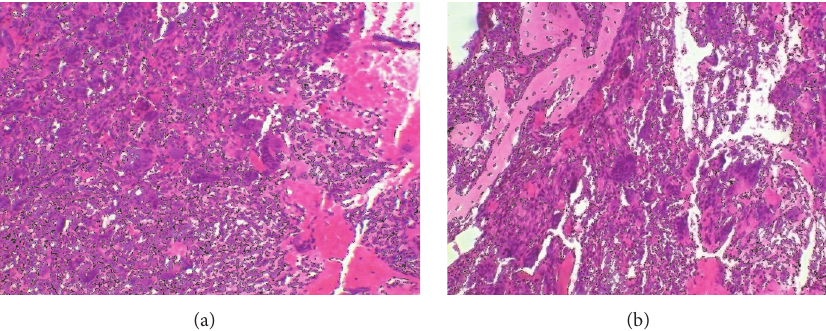
Figure 5: (a) Photomicrograph of 10x view shows numerous multinucleated giant cells and hemorrhagic areas. (b) Photomicrograph of 40x view shows multinucleated giant cells of varying size and shape and areas of osteoid.